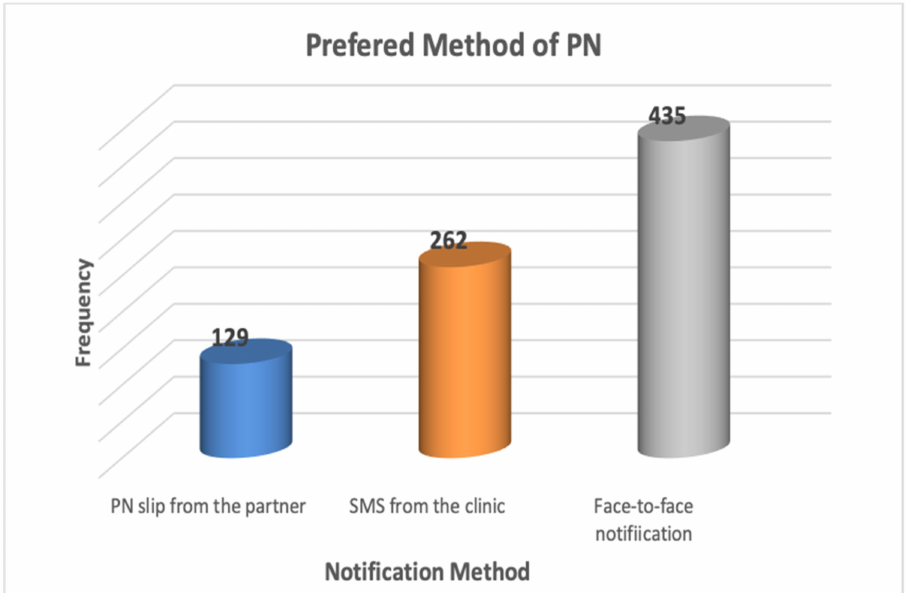
Figure 1. Preferred method of STI